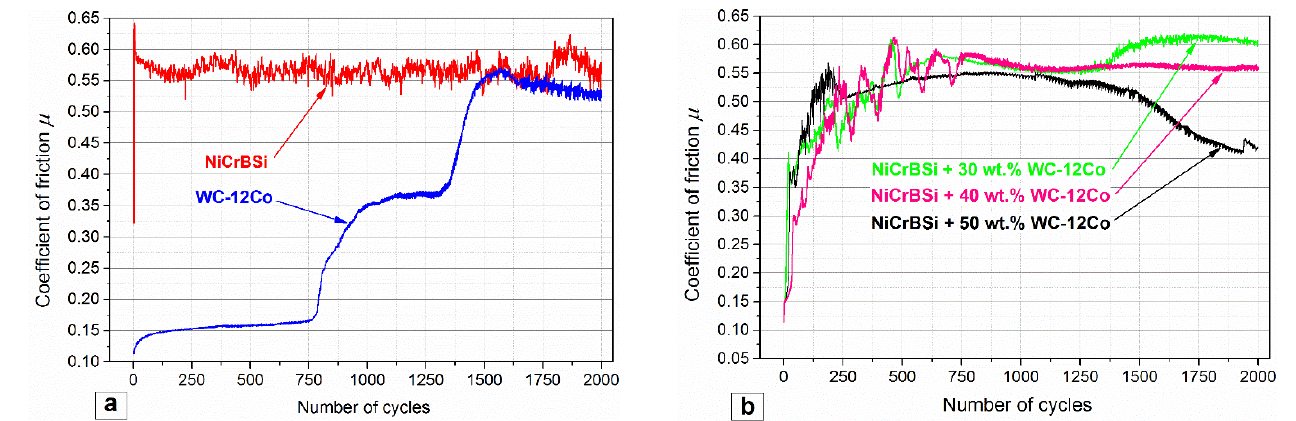
Figure 9. Depth of wear tracks from profile measurements: ( a ) NiCrBSi, ( b ) NiCrBSi + 30 wt.% WC-